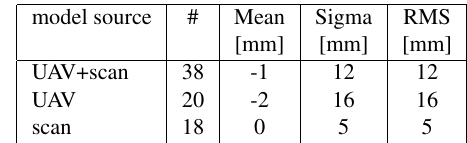
Table 5. Statistics of the difference between the